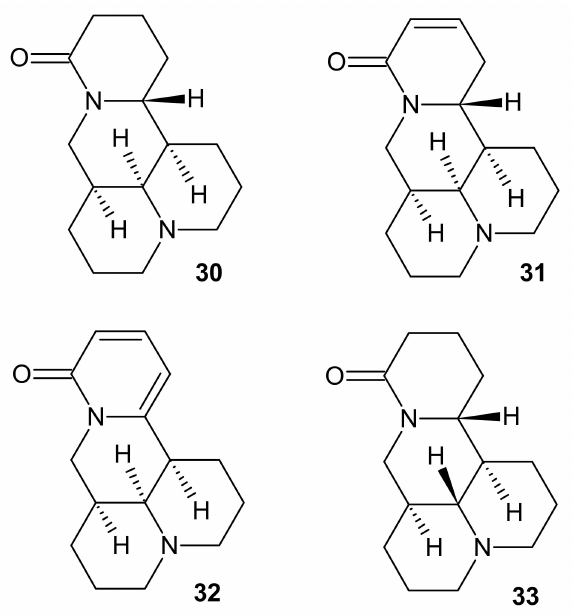
Figure 10. Structures of the Sophora alkaloids 30 – 33